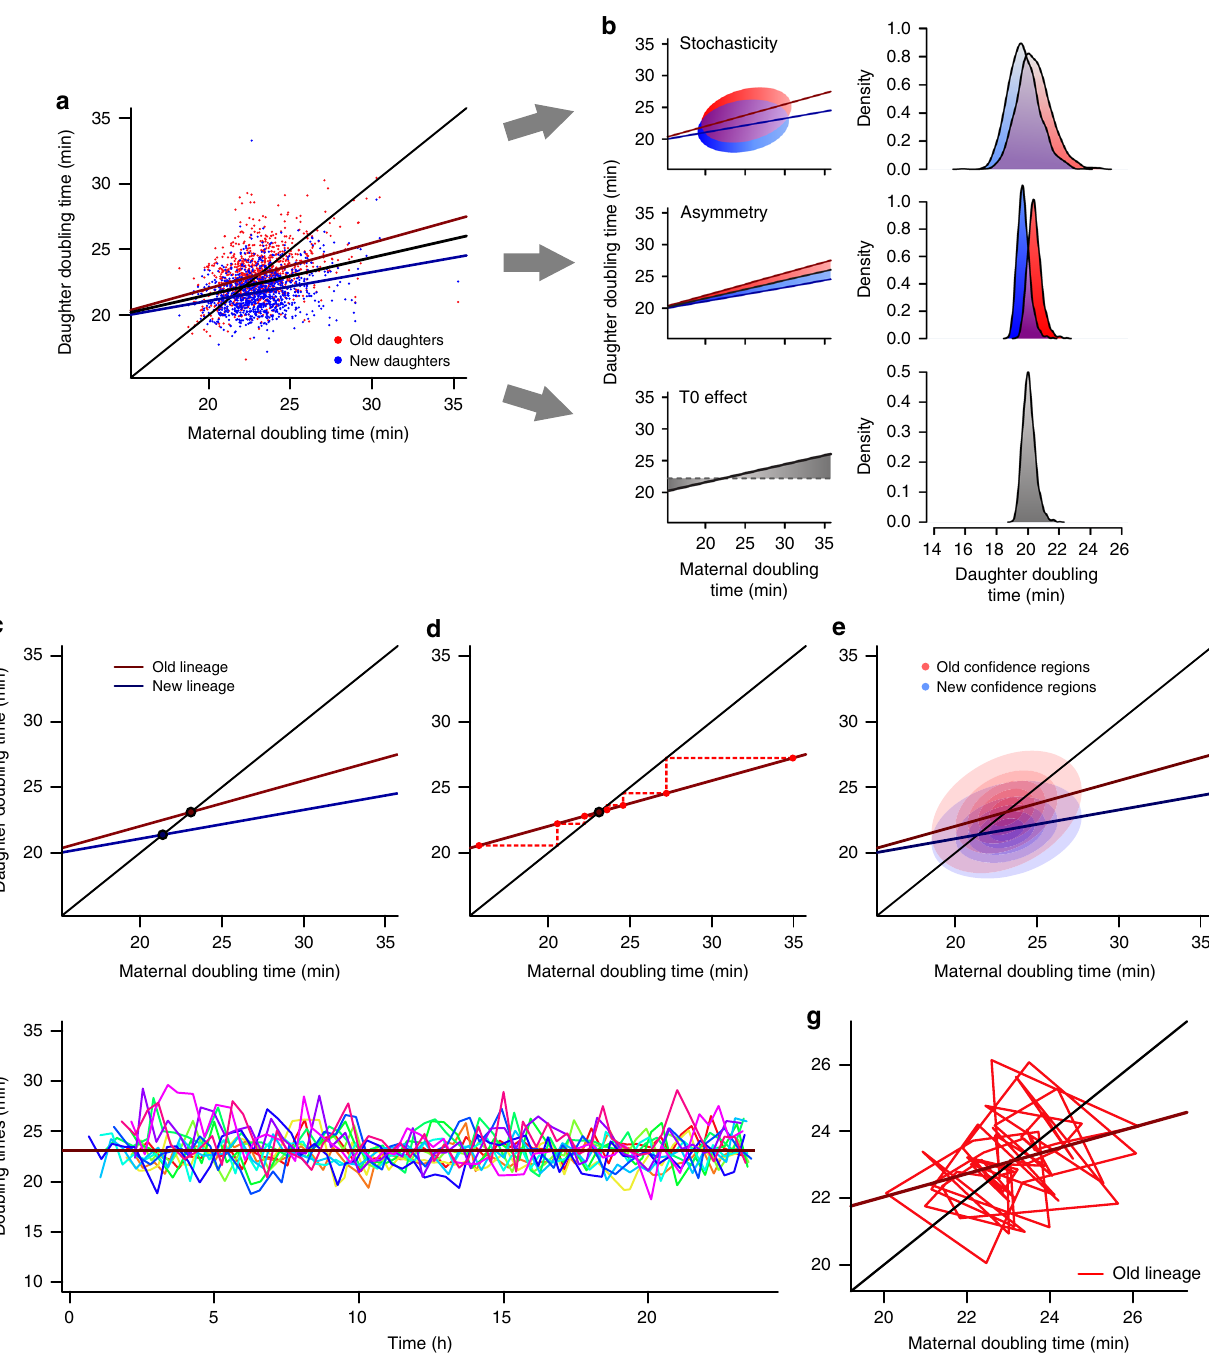
Fig. 3 Doubling time relationships predict stabilization at equilibrium points. a Old daughters (23.127 ± 1.903 min, n = 987 cells) displayed longer doubling times than their new siblings (21.778± 1.517 min, n = 987 cells) in the mother machine ( t = − 21.884, df = 986, p < 0.001, paired one-tailed t -test), resulting in a separation between new and old subpopulations in the phase plane. b The variance in T1 and T2 was partitioned into three components through the estimation of sum of squared deviations. Left: shaded areas represent the variability explained by each component. Maternal doubling times explain the deviation from the population mean; asymmetry explains the deviation from values predicted by T0 alone; and stochasticity explains the deviation of observed T1 and T2 from values predicted by asymmetry. Right: Density distributions showing increasing variance as more components are added to doubling time estimates. c As the slopes of linear models between T0 and T1 or T2 are shallower than the identity line, stable points arise at the intersection between these lines and identity. d Graphical representation of T2 lineages converging toward the predicted equilibrium through the continuous inheritance of old poles. e Most of the data points concentrated around the predicted attractors, as shown by ellipse-like con fi dence regions ranging from 15% to 95% con fi dence. f Doubling times of old lineages from the mother machine shown over 24 h, as 13 independent lineages ( n = 745 cells) remain stable over time. g Progression of a randomly chosen old lineage around the predicted equilibrium, which behaves as an attractor for the dynamic trajectory of the lineage over 60